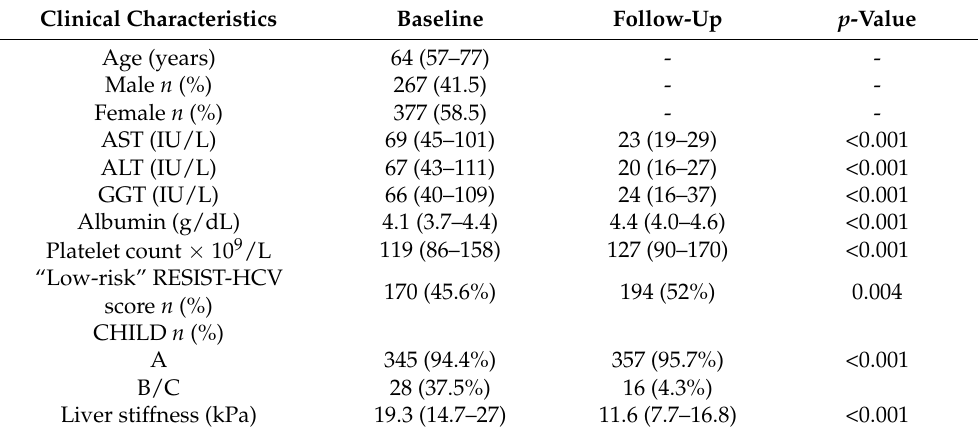
Table 1. The baseline clinical characteristics of the study cohort (N =